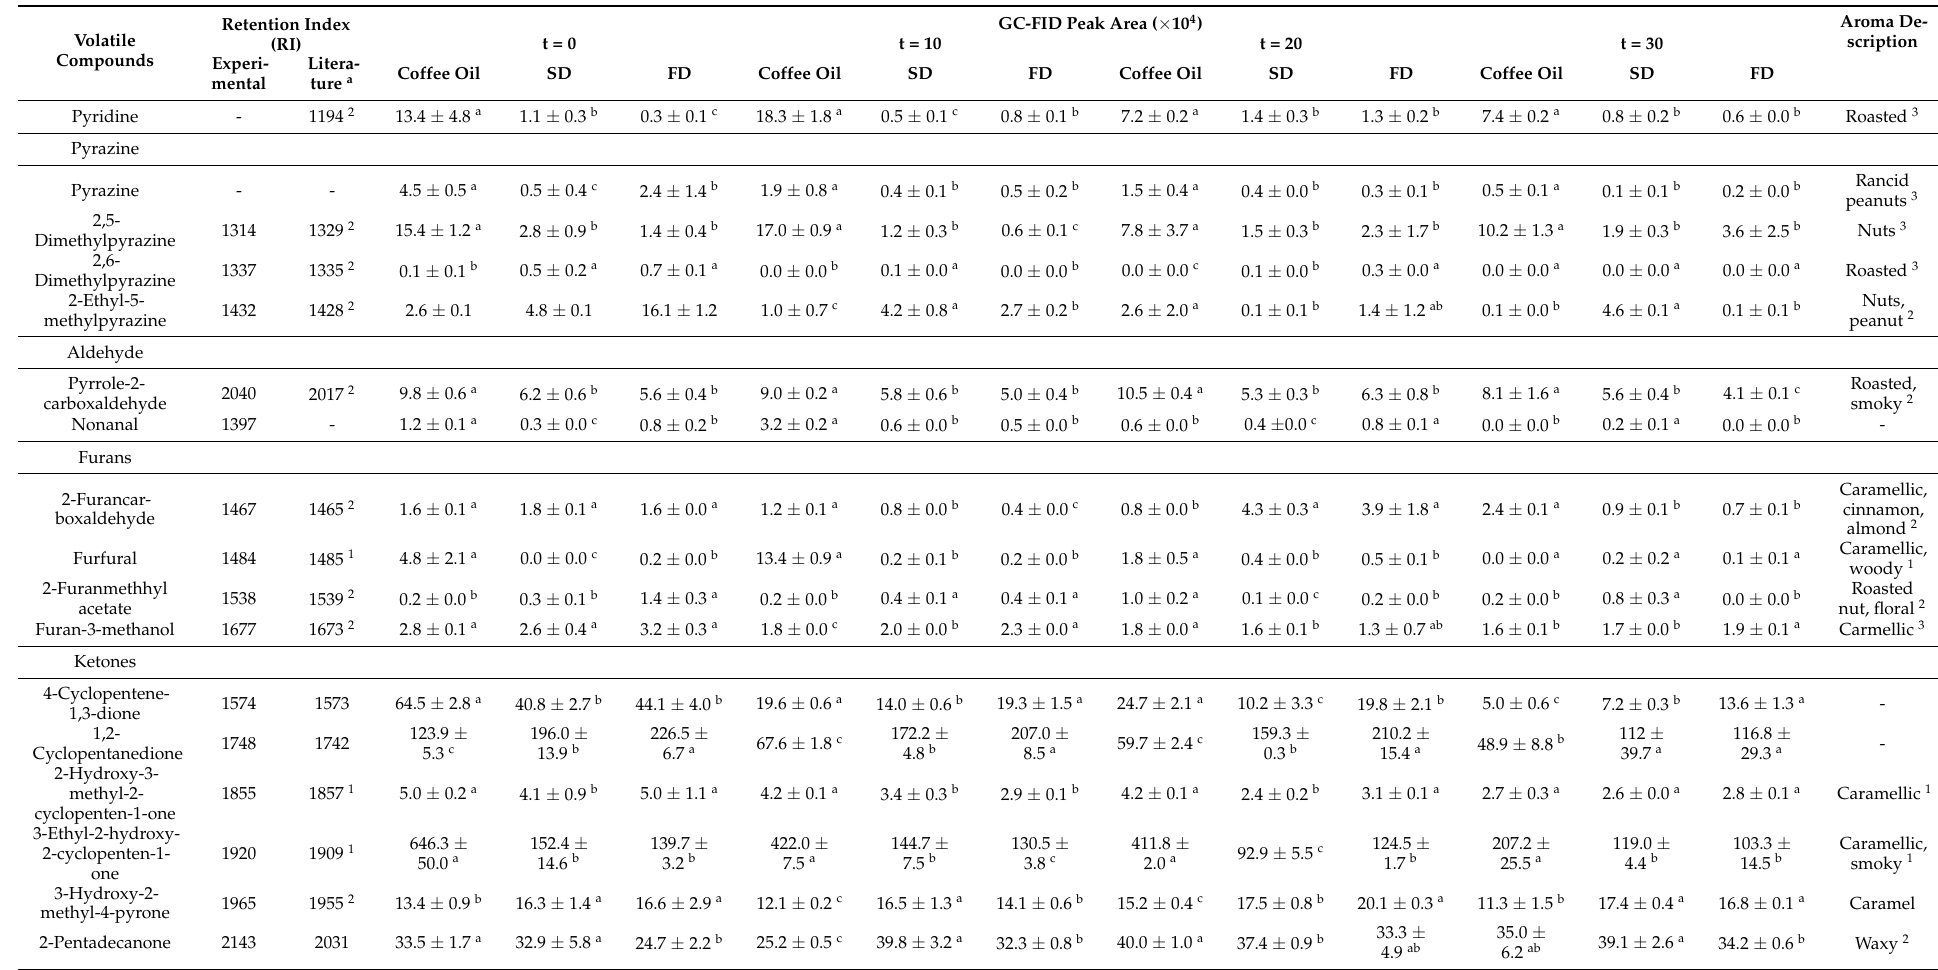
Table 3. Volatile aroma compounds of the non-encapsulated roasted coffee oil (RCO) and microcapsules of RCO produced by spray-drying (SD) and freeze-drying